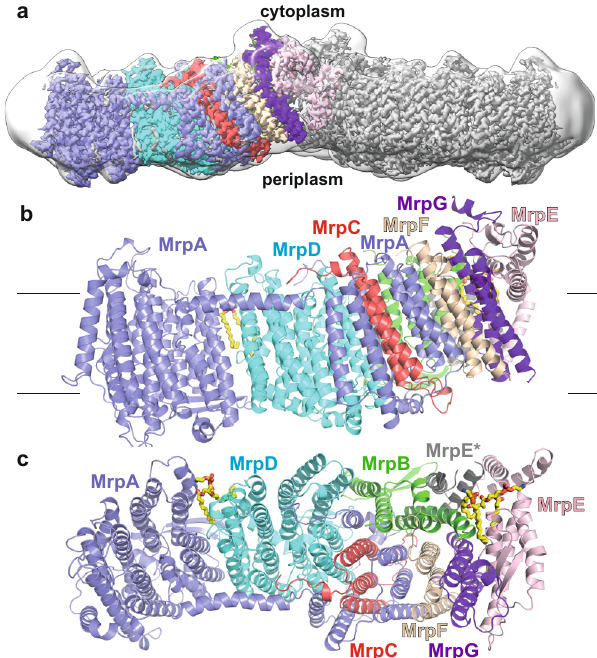
Fig. 1 | Overall structure of B. pseudo fi rmus Mrp Na + /H + antiporter. a CryoEM density for a dimer, b side view with approximate positions of membrane bound- ariesand c topviewofaprotomercomprisingthesevensubunitsMrpA – MrpGand apartialmodelofMrpEfromanadjacentmonomer(MrpE*).In( a )theunstructured detergent belt gives an indication of the approximate position of the membrane